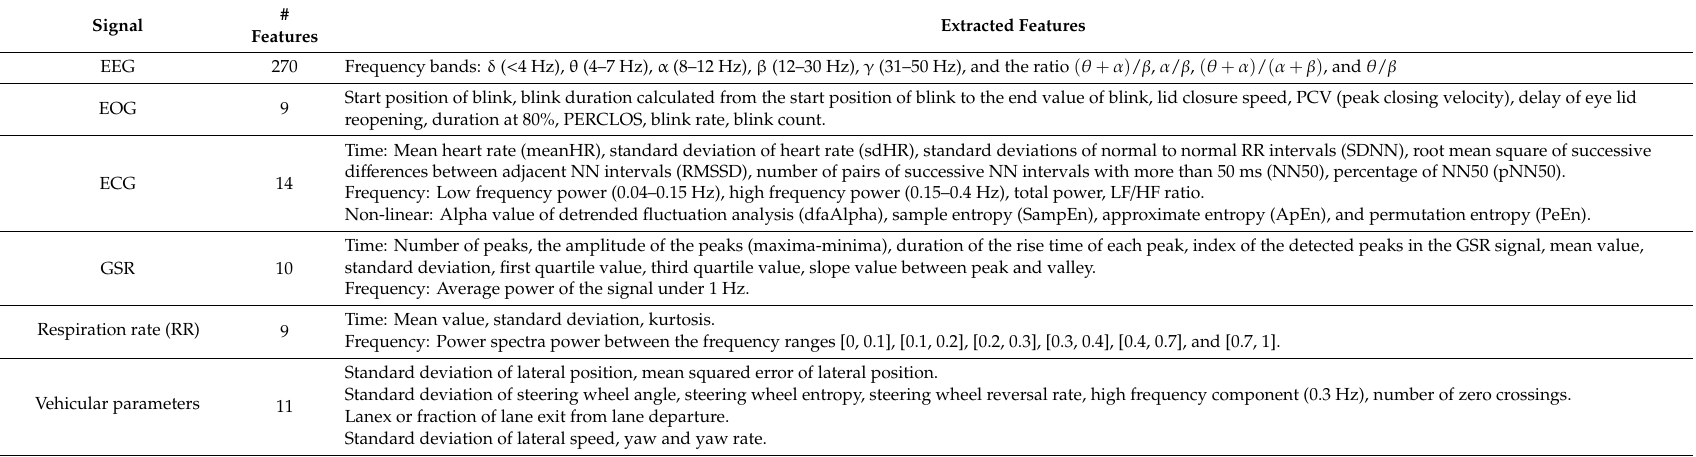
Table 1. List of features extracted from each signal. # represent